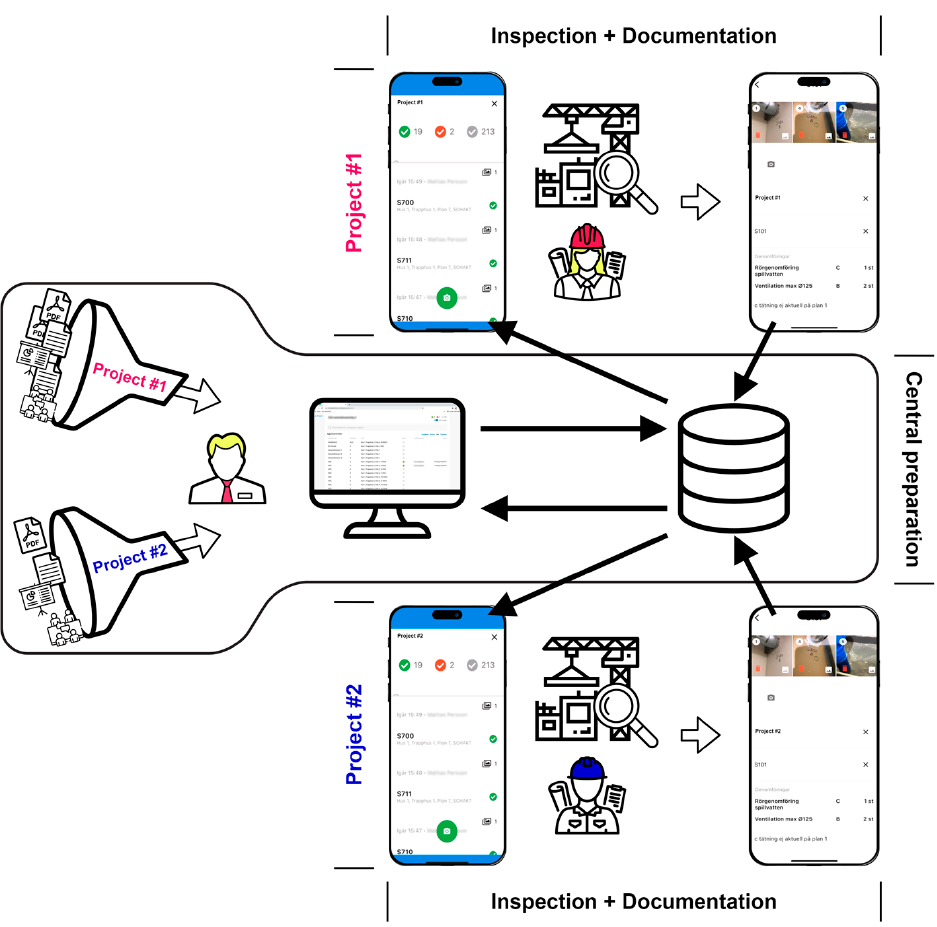
Figure 2. Central preparation utilizing DQCS to support construction sites’ work of inspection and documentation.